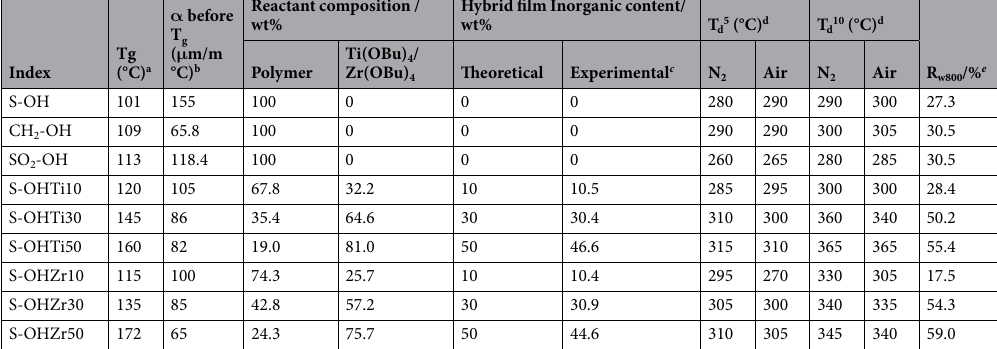
Table 1. Thermal properties of PITEs and S-OH hybrid films with TiO 2 and ZrO 2 . a Glass transition temperature and CTE data were as determined TMA measurements. b Experimental content of inorganic part measured from TGA curves in air. c Temperature at which 5% and 10% weight loss, and Residual weight percentages under nitrogen flow at 800 °C were also measured by TGA.